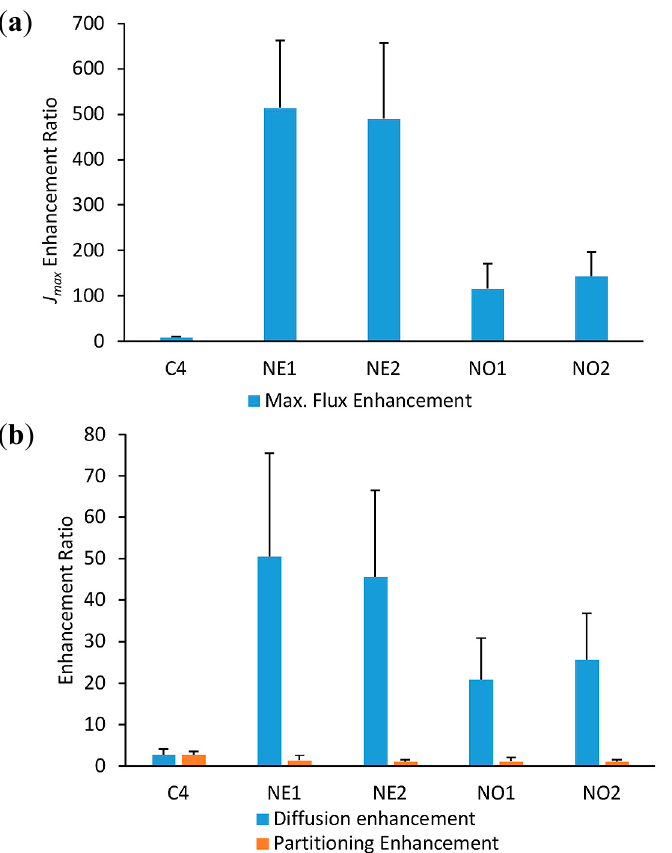
Figure 2. Minoxidil skin permeation enhancement ratios for the 60% ethanol/water formulation (C4) and the four nanoemulsions containing eucalyptol (NE1, NE2) or oleic acid (NO1, NO2), compared to the mean values for the three aqueous control solutions (C1, C2, C3). ( a ) J max and ( b ) derived diffusivity ( D* ) and formulation–stratum corneum partition coefficient, K f-sc .